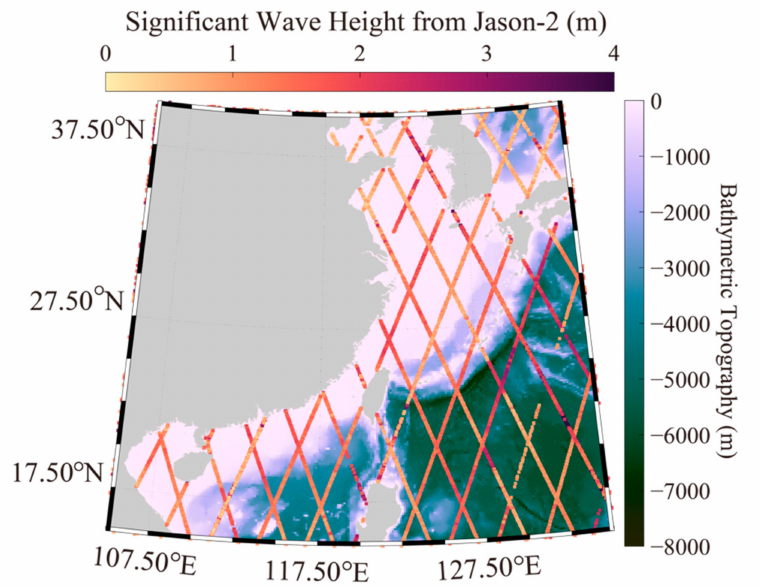
Figure 3. The significant wave height (SWH) in the path of the satellite from July 1 to July 30 2015, overlaid with water